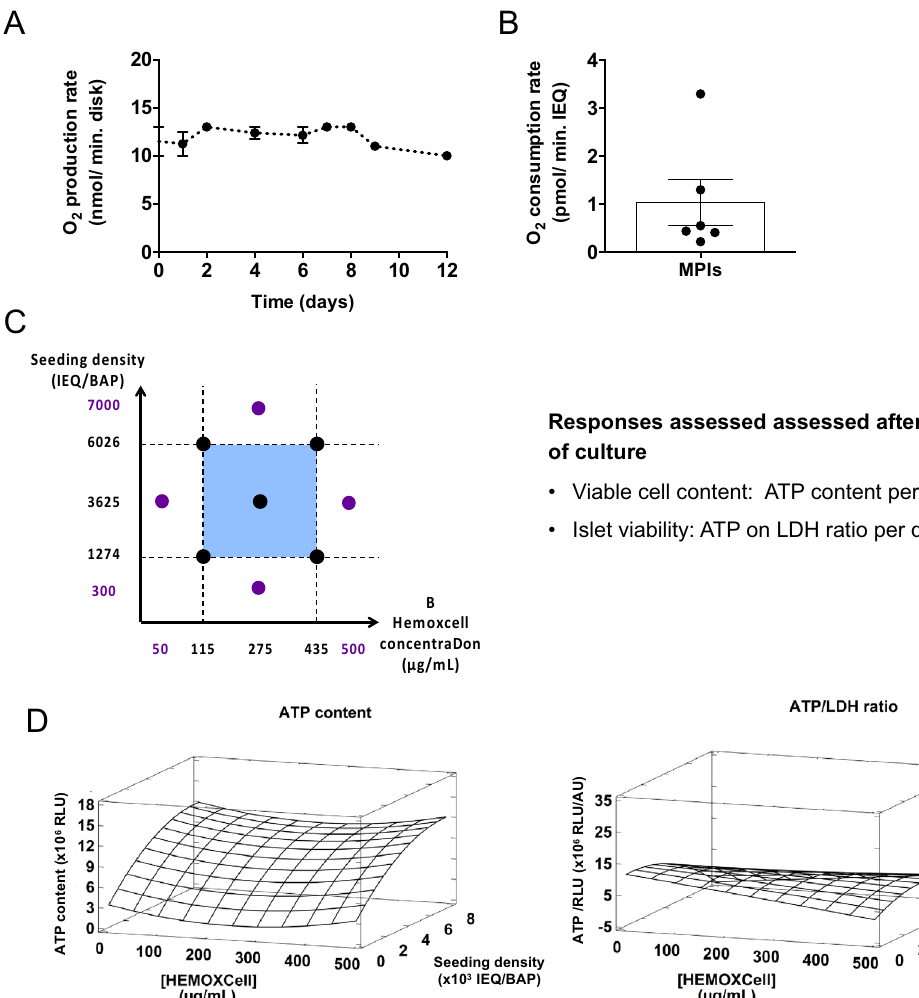
Figure 2. Optimization experimental design. Based on ( A ) the silicone-CaO 2 O 2 production rate and ( B ) the MIN6 pseudo-islet O 2 consumption rate, ( C ) a central composite design was used to optimize the HEMOXCell concentration and islet seeding density in the BAP. The response variables, intracellular ATP content (RLU), and ATP/LDH viability ratio (RLU/AU) per device were assessed for MPIs encapsulated in alginate sheets after 1 day of culture. Results of O 2 production rate (n = 2) and consumption rate (n = 6) are presented as mean ± SEM of independent experiments. ( D ) Response surface analysis for the optimization DoE. The plots represent the effects of the HEMOXCell concentration, islet seeding density, and their interaction on the ATP content and the ATP/LDH ratio in the BAP after 1 day of culture under 1% O 2